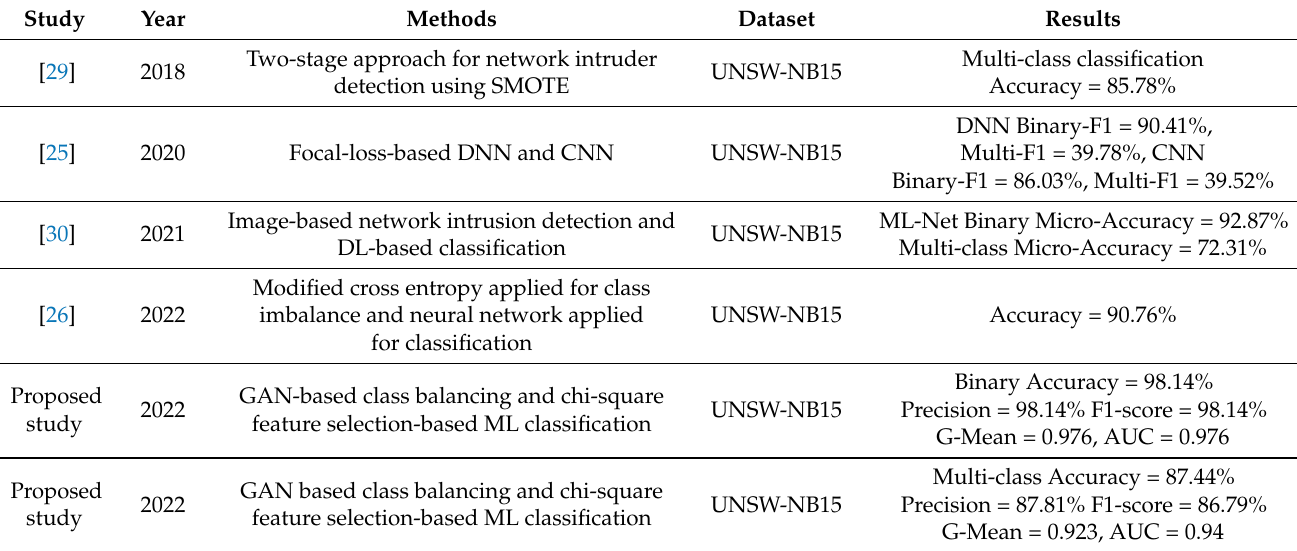
Table 7. Comparative analysis of UNSW-NB15 dataset with respect to recently applied state-of-the-art